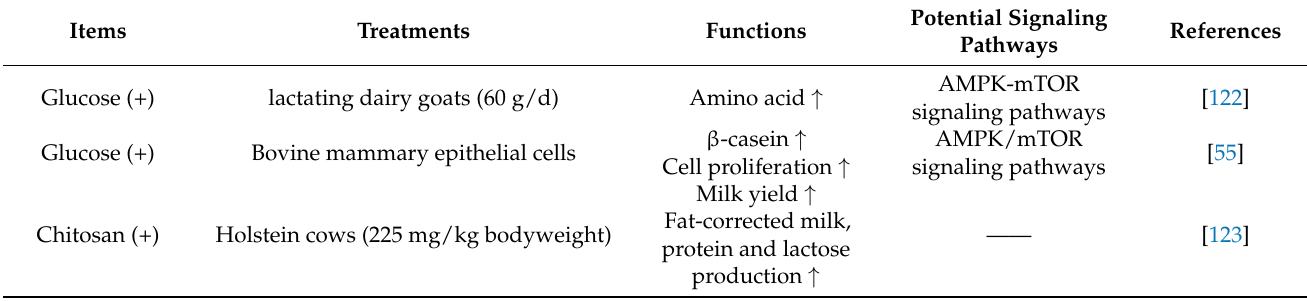
Table 4. Effects of carbohydrates on milk production and its potential regulatory